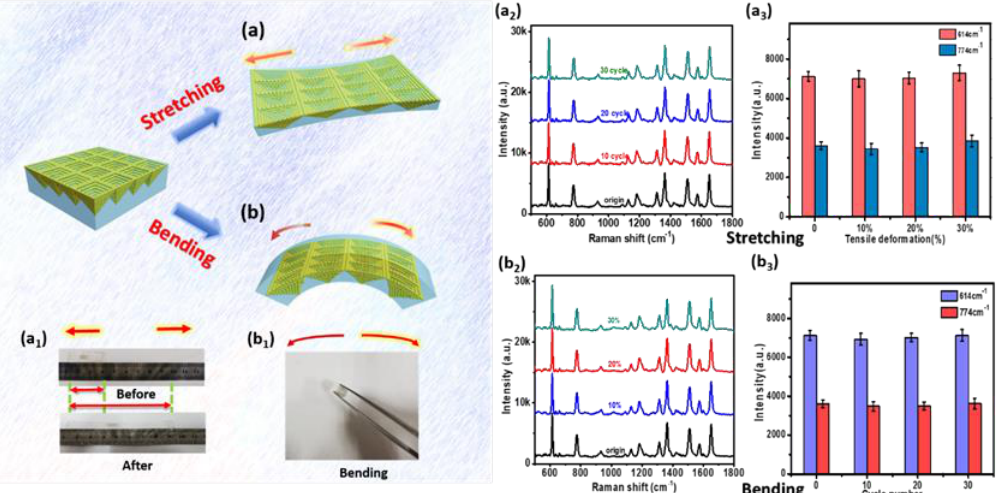
Figure 6. Durability tests with mechanical stimuli of the P–AgNPs@PMMA substrate. Schematic illustration: comparative Raman spectra and the SERS intensity of R6G at 614 and 774 cm −1 peaks; ( a )